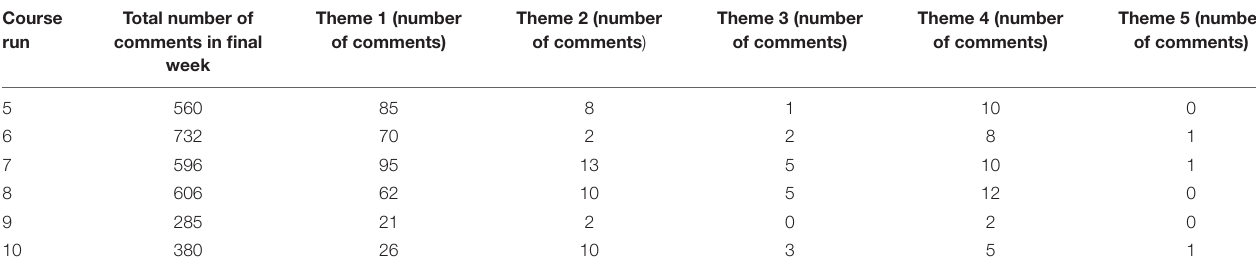
TABLE 2 | Emerging themes of developing ocean literacy in the Exploring our Oceans MOOC (runs 5–10, 4-week version only). Course